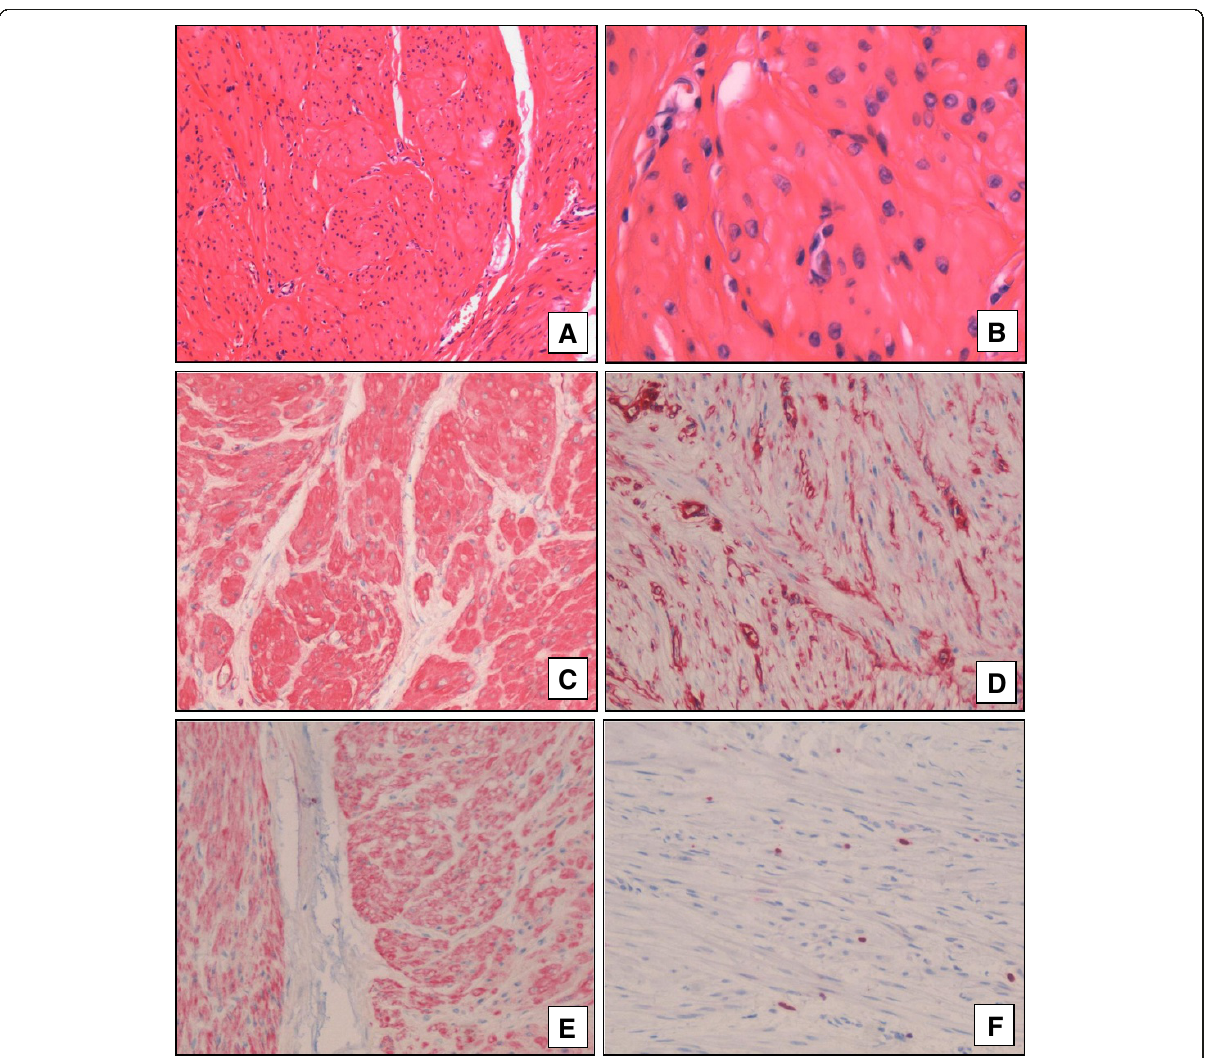
Figure 3 Histollogically interlacking smooth muscle bundles are seen (A, x40; B, x200). Immunohistologically Actin (C, x100) , Vimentin (D, x100) and Desmin (E, x100) show positive expression pattern. In the Ki-67 staining no increased proliferation activity could be detected (F, x100)